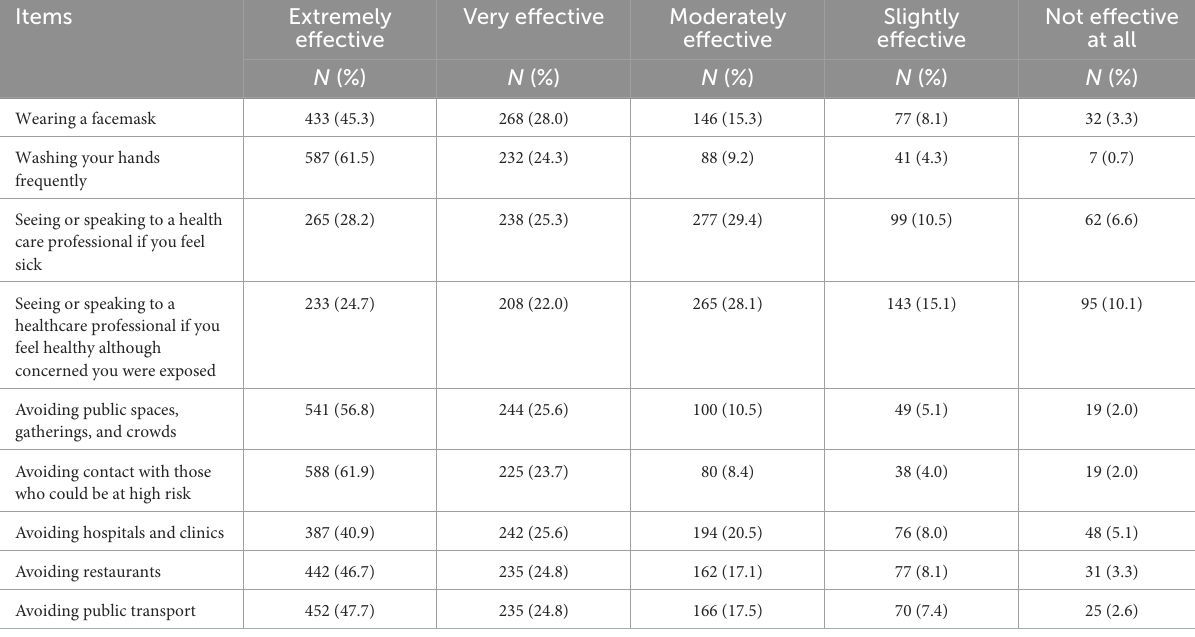
TABLE 7 Attitudes toward the effectiveness of protective measures to keeping you safe from COVID-19. Items Extremely effective